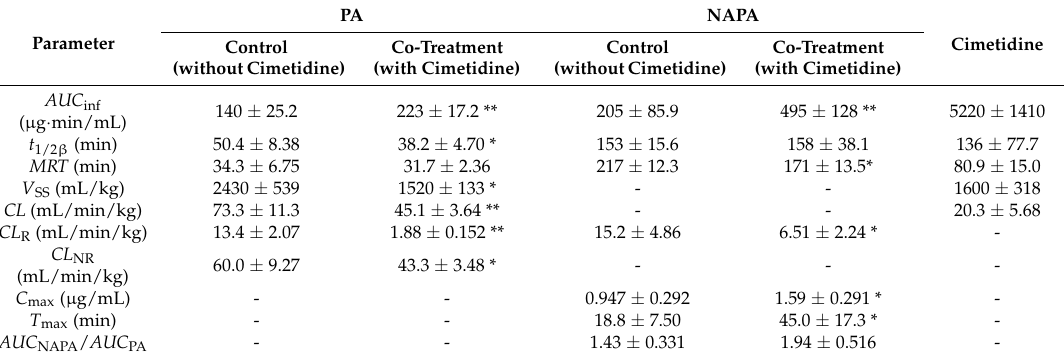
Table 4. Observed pharmacokinetic parameters of PA, NAPA (after intravenous administration of 10 mg/kg PA HCl) and cimetidine (after intravenous administration of 100 mg/kg cimetidine) ( n = 4 for each group).